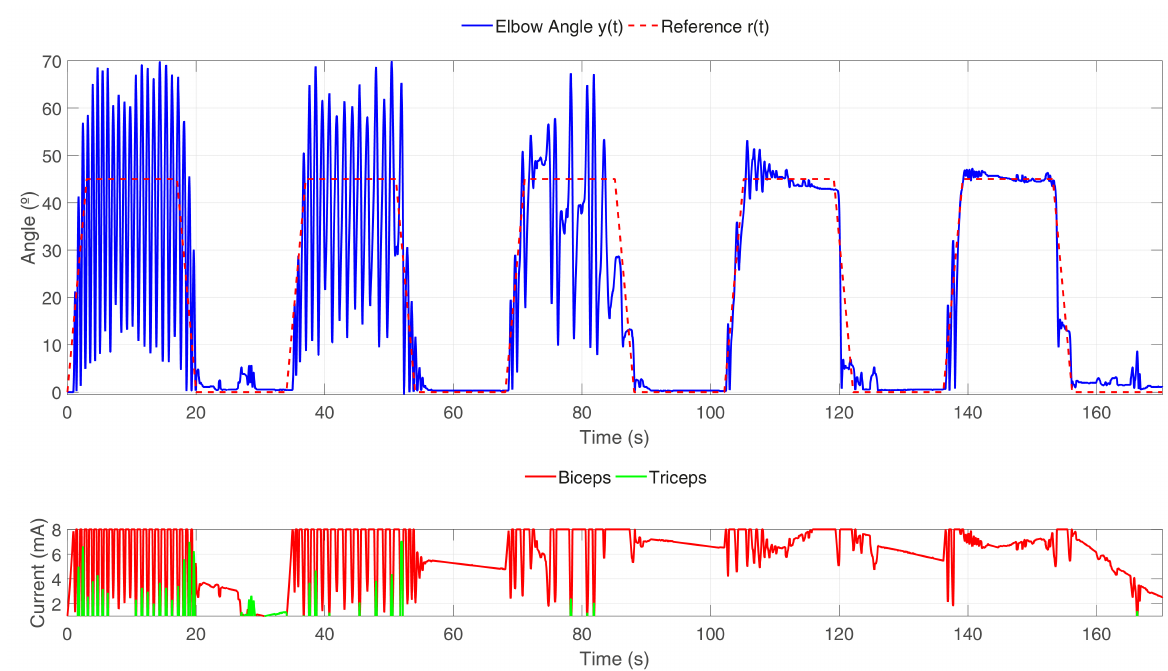
Figure 6 - Adaptive PID (volunteer 1): response y and reference r ; control signal u .